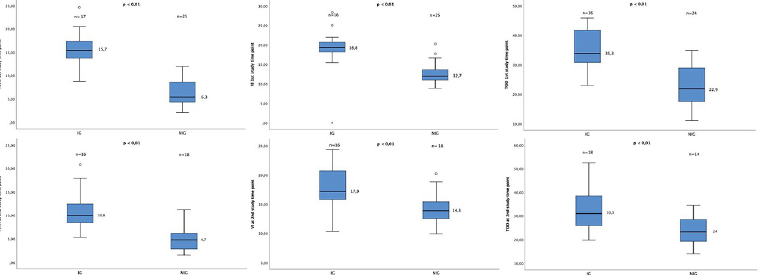
Fig 2. Ventricular width by study group. Ventricular measurements (AHW, IV and TOD) at the first study timepoint prior to intervention (IG) compared with the worst cUS (NG) in the upper panel, and at the second study timepoint (TEA) in lower panel. Ventricular size was significantly larger in the IG than in the NG prior to intervention and at TEA. Ventricular values are presented as median ± IQR (mm). Abbreviations: AHW, anterior horn width; IV, ventricular index; TOD, thalamo-occipital distance; IG, intervention group; NG, non-intervention group; cUS, cranial ultrasound; TEA, term equivalent age; IQR, interquantile